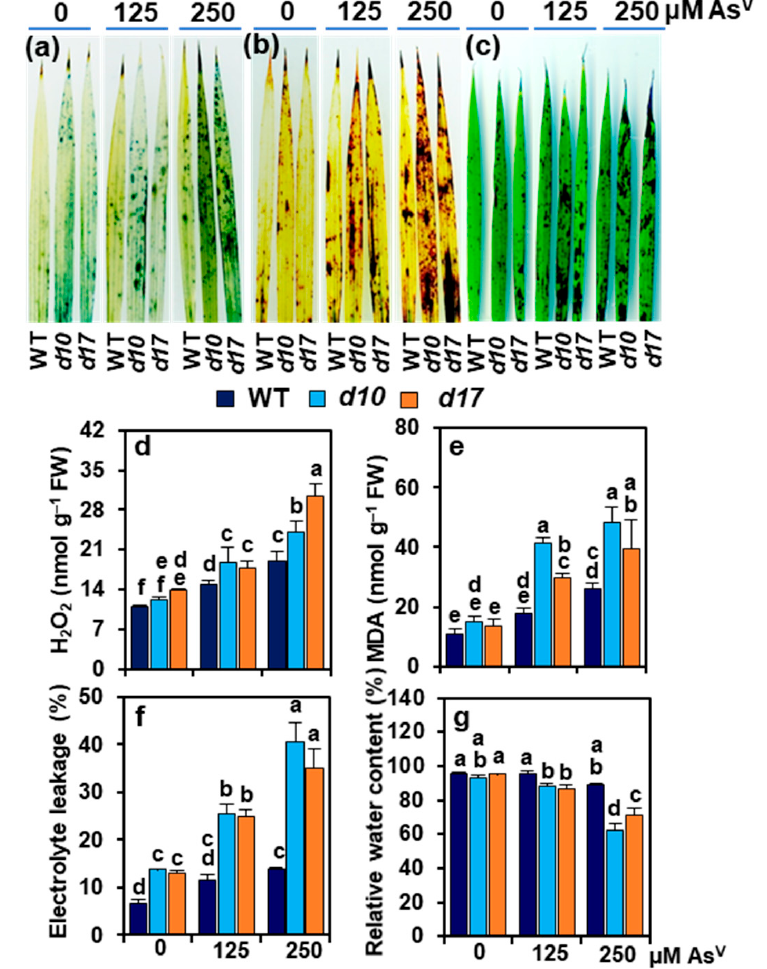
Figure 4. ( a – g ) Oxidative stress-related parameters in wild-type (WT) and d10 and d17 mutant plants exposed to different concentrations of sodium arsenate (Na 2 AsO 4 ; 0, 125 and 250 µ M As V ). ( a – c ) Leaf staining for detection of superoxide (O 2 • − ) by nitroblue tetrazolium ( a ), hydrogen peroxide (H 2 O 2 ) by diaminobenzidine ( b ), and cuticle damage by toluidine blue ( c ). ( d – g ) The levels of H 2 O 2 ( d ), malondialdehyde (MDA), electrolyte leakage ( f ) and relative water contents ( g ) in the shoots of the three genotypes were recorded on day 3 of As V treatments. Represented numerical data are the means with standard errors ( n = 3 biological repeats). Significant differences ( p < 0.05) among the treatments are denoted by distinct alphabetical letters according to a least significant difference test. FW, fresh